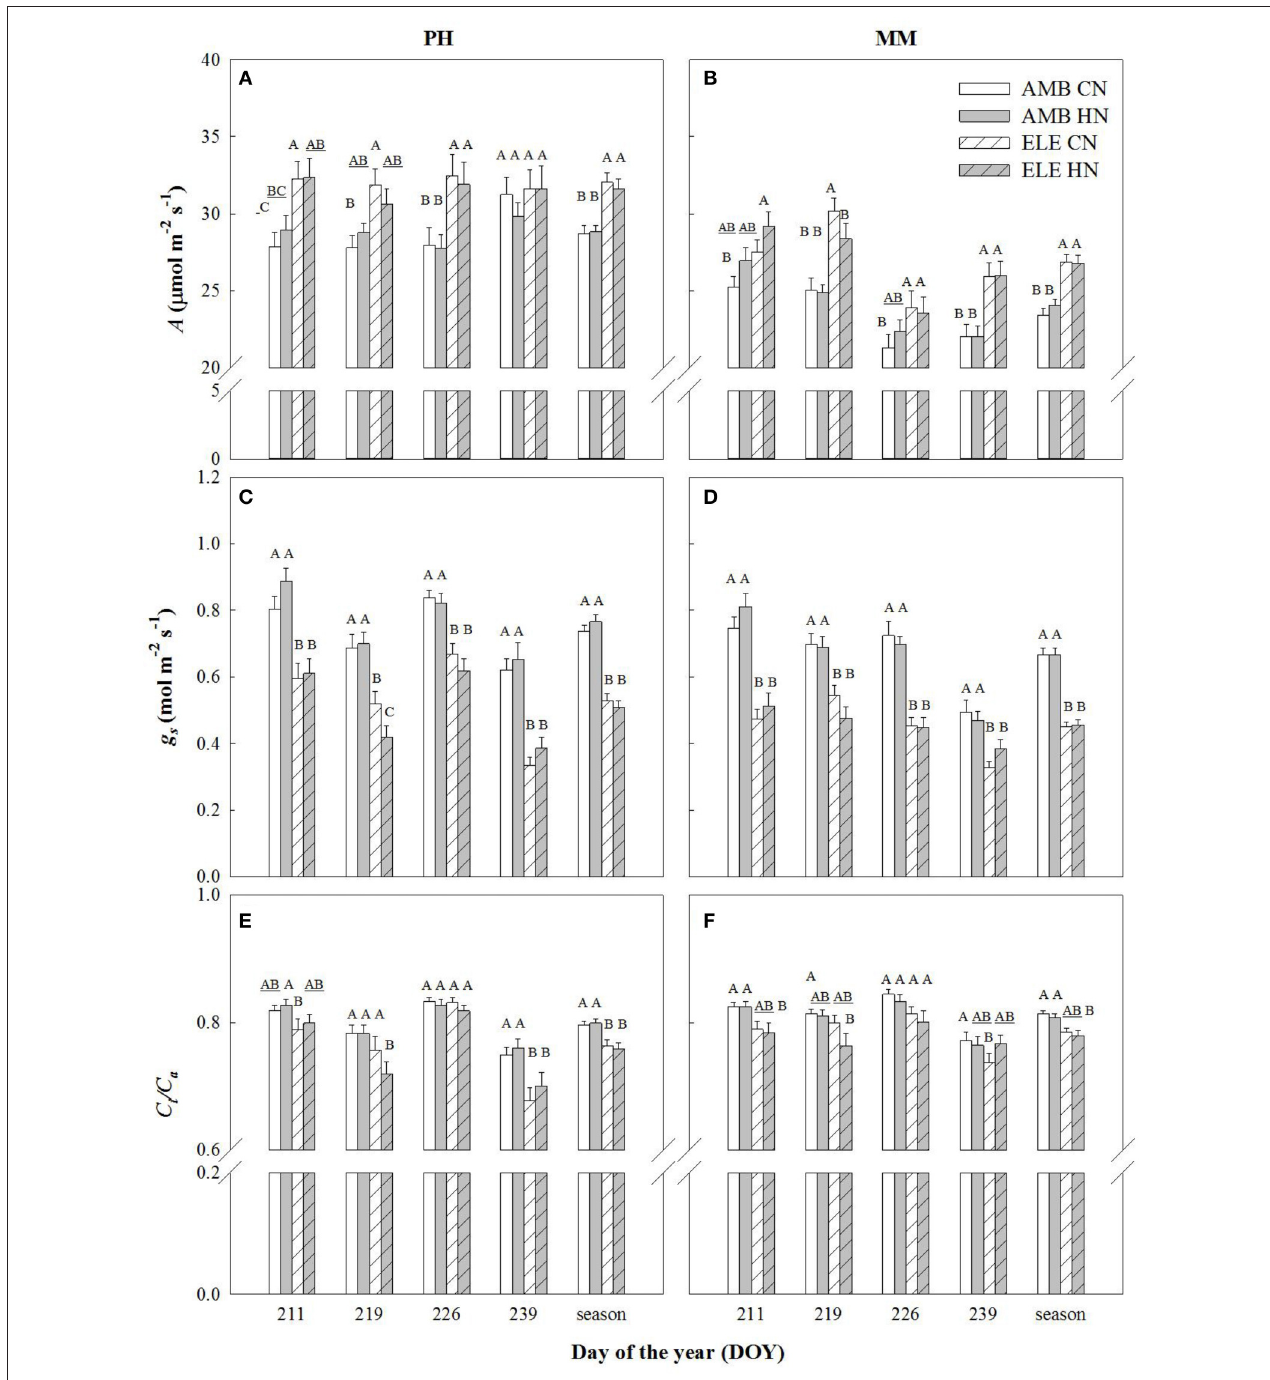
FIGURE 1 | Photosynthetic leaf CO 2 uptake ( A ; A,B ), stomatal conductance ( g s ; C,D ), and the ratio of internal [CO 2 ] to the atmospheric [CO 2 ] ( Ci / Ca ; E,F ) in tobacco cultivars Petit Havana (PH) and Mammoth (MM). Bars represent the DOY and season average values for each treatment. AMB CN, ambient [CO 2 ] and control N; AMB HN, ambient [CO 2 ] and high N; ELE CN, elevated [CO 2 ] and control N; ELE HN, elevated [CO 2 ] and high N. Error bars are mean ± standard error (SE). Treatments with different letters represent statistically significant differences ( p < 0.1).